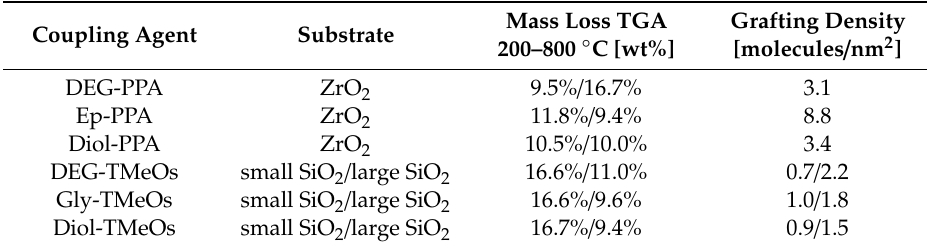
Table 2. Surface coverage of the nanoparticle substrates, grafting densities determined from TGA / nitrogen sorption